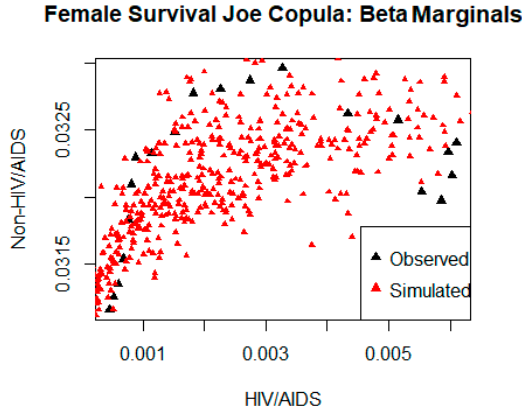
Figure 13. Beta marginal distribution for females.